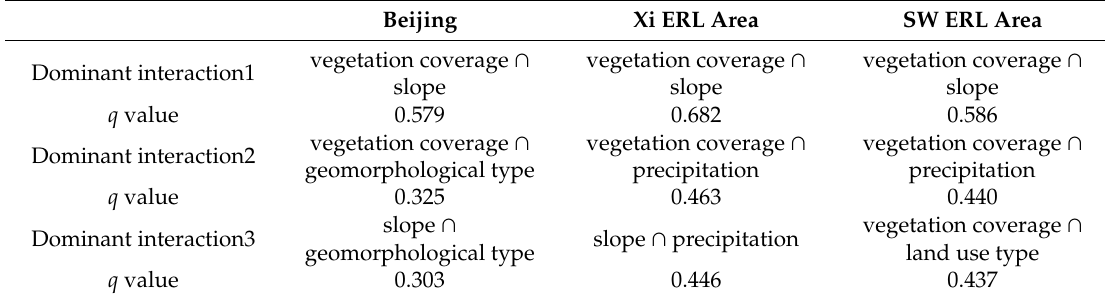
Table 4. The dominant interactions of factors a ff ecting soil erosion in soil conservation ERL areas. Beijing Xi ERL Area SW ERL Area Dominant